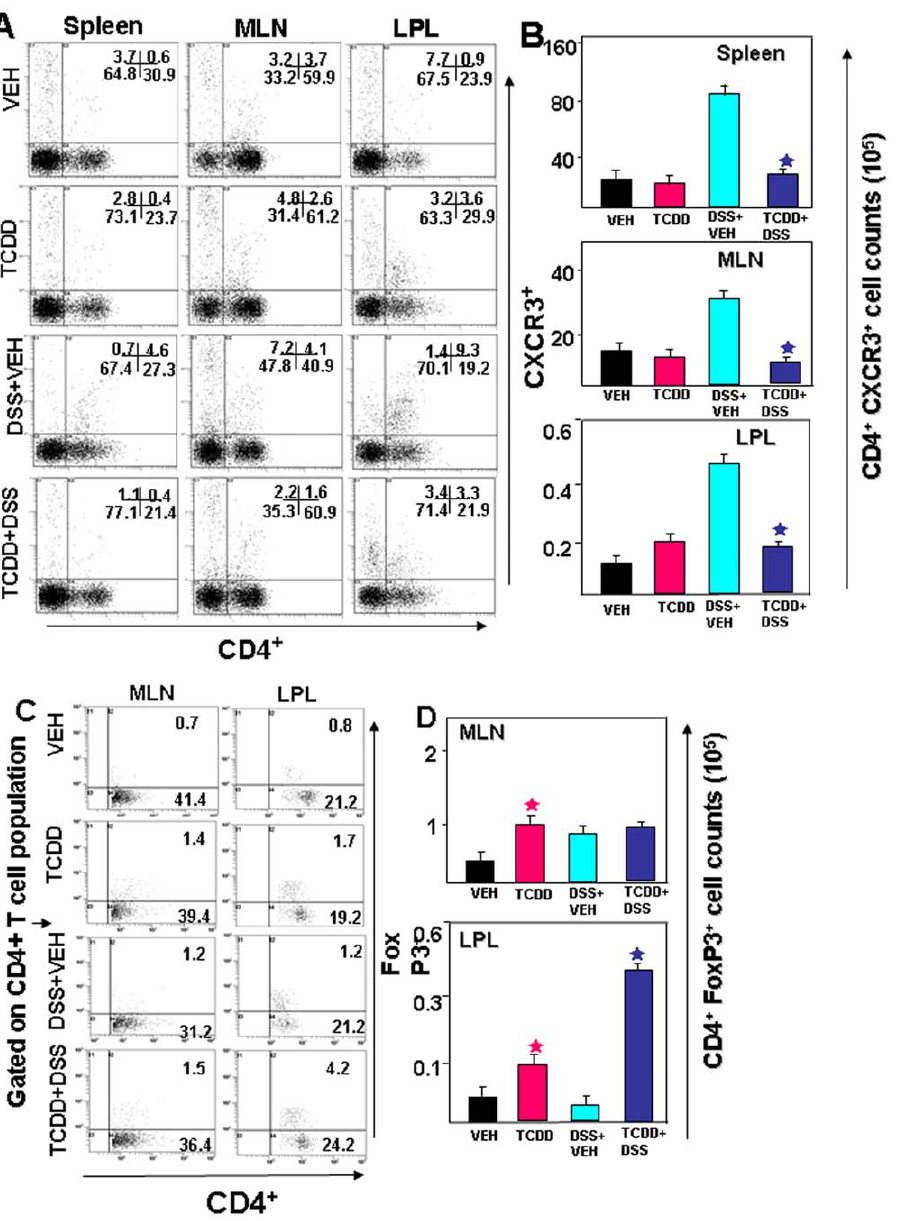
Figure 2. Effect of TCDD on CD4 + CXCR3 + in cells from spleen, MLN and LP and generation of Tregs in the LP following development of DSS-induced colitis. A–B. Splenic MLN and LP cells were isolated from the four groups of mice as described in Fig 1, stained for CD4 + CXCR3 + T cells, and analyzed using flow cytometry. A representative experiment is shown in panel (A), indicating the percentage of CD4 + CXCR3 + T cells, and absolute numbers (mean 6 SEM) of these cells from groups of 6 mice are depicted in panel B. Asterisks (*) indicate statistically significant differences with p , 0.01 between DSS + VEH versus DSS + TCDD treated group. C–D. MLN and LP cells were isolated from the 4 groups of mice and stained for CD4 + Foxp3 + cells. A representative experiment is shown in panel C, and absolute numbers (mean 6 SEM) of these cells from groups of 6 mice are depicted in panel D. Asterisks (*) indicate statistically significant differences (with p , 0.01) between VEH versus TCDD alone and DSS + VEH versus DSS + TCDD treated group.